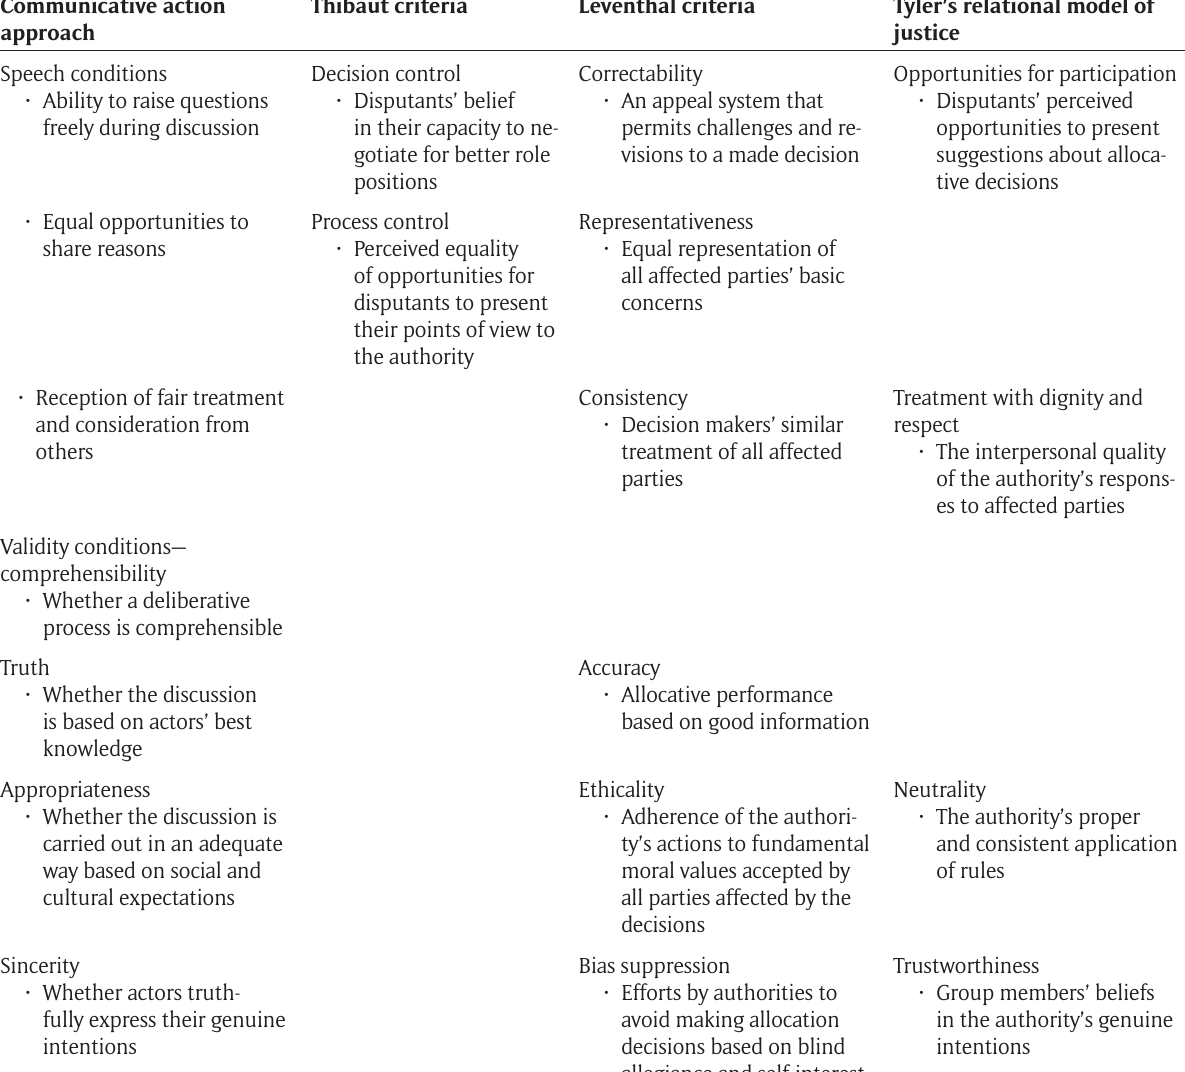
Table 1: The compatibility properties of speech and validity conditions. Communicative